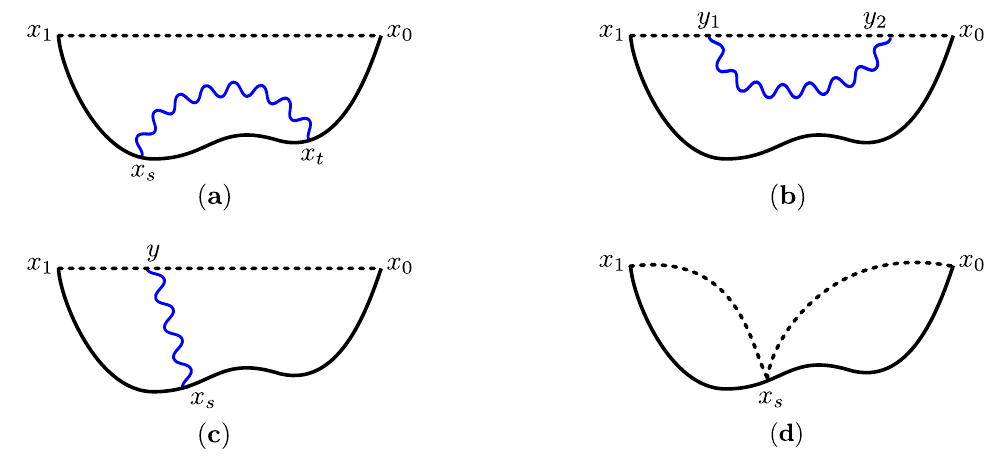
Figure 4 . All one-loop diagrams that contribute to the expectation value of the mesonic opera- tor (2.3). The dashed line represents the scalar propagator and the solid black line represents the Wilson line. Diagram ( d ) has the scalar bi-linear inserted on the